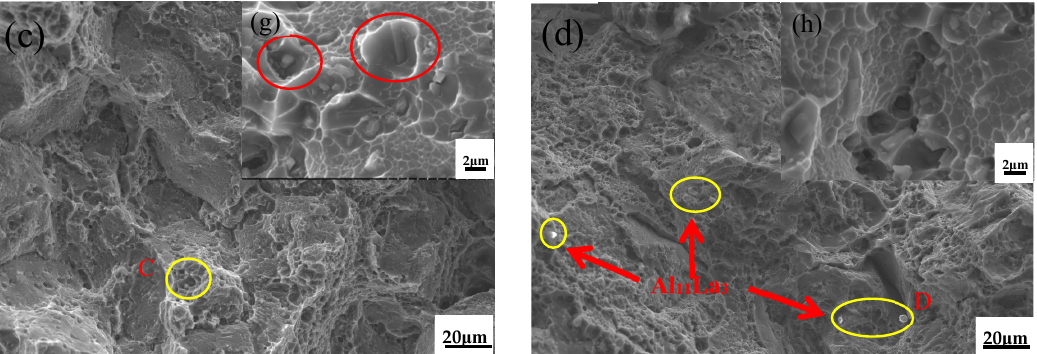
Figure 6. Fracture surface of the T5 heat-treated alloys after room-temperature tensile tests: ( a ) ZL205A alloy, ( b ) ZL205A + 0.1%La alloy, ( c ) ZL205A + 0.3%Al–5Ti–0.8C alloy, ( d ) ZL205A + 0.1%La + 0.3%Al– 5Ti–0.8C alloy, ( e ) Enlarged image of area A, ( f ) Enlarged image of area B, ( g ) Enlarged image of area C, ( h ) Enlarged image of area D.